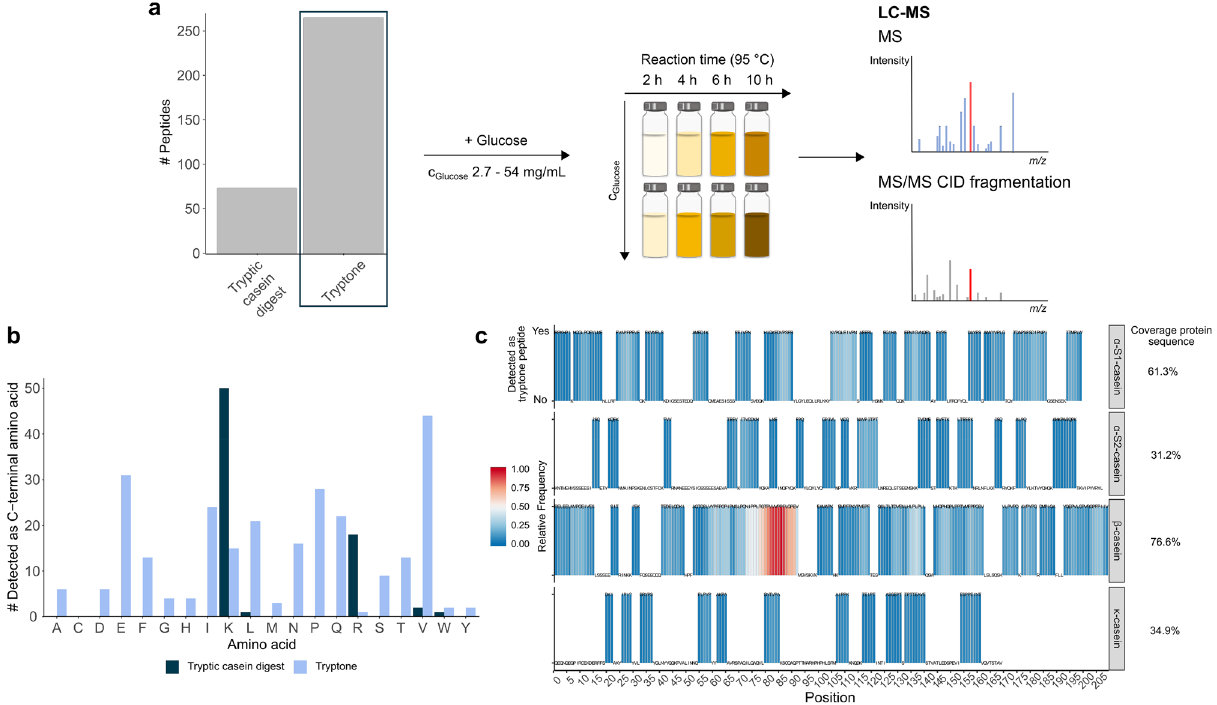
Figure 1. Analysis of tryptone glucose model systems by UHPLC-QTOF-MS. (a) Experimental design—high- resolution mass spectrometry was used to analyze tryptone glucose model systems and for the identification of site-specific non-enzymatic glycation. ( a) The bar plot illustrates the number of peptides provided by an in silico tryptic casein digest (72) compared to tryptone (264). ( b) A bar plot shows the number of C-terminal amino acids observed for tryptone peptides (light blue) and a theoretical casein digest by trypsin (dark blue). Tryptic digestion predominantly forms peptides with C-terminal lysine or arginine. ( c) A casein protein heatmap represents how often (relative scale) detected tryptone peptides covered the same amino acid sequence in the proteins, showing which protein substructures contribute to peptide heterogeneity of the model systems. Dipeptides were removed for more sequence